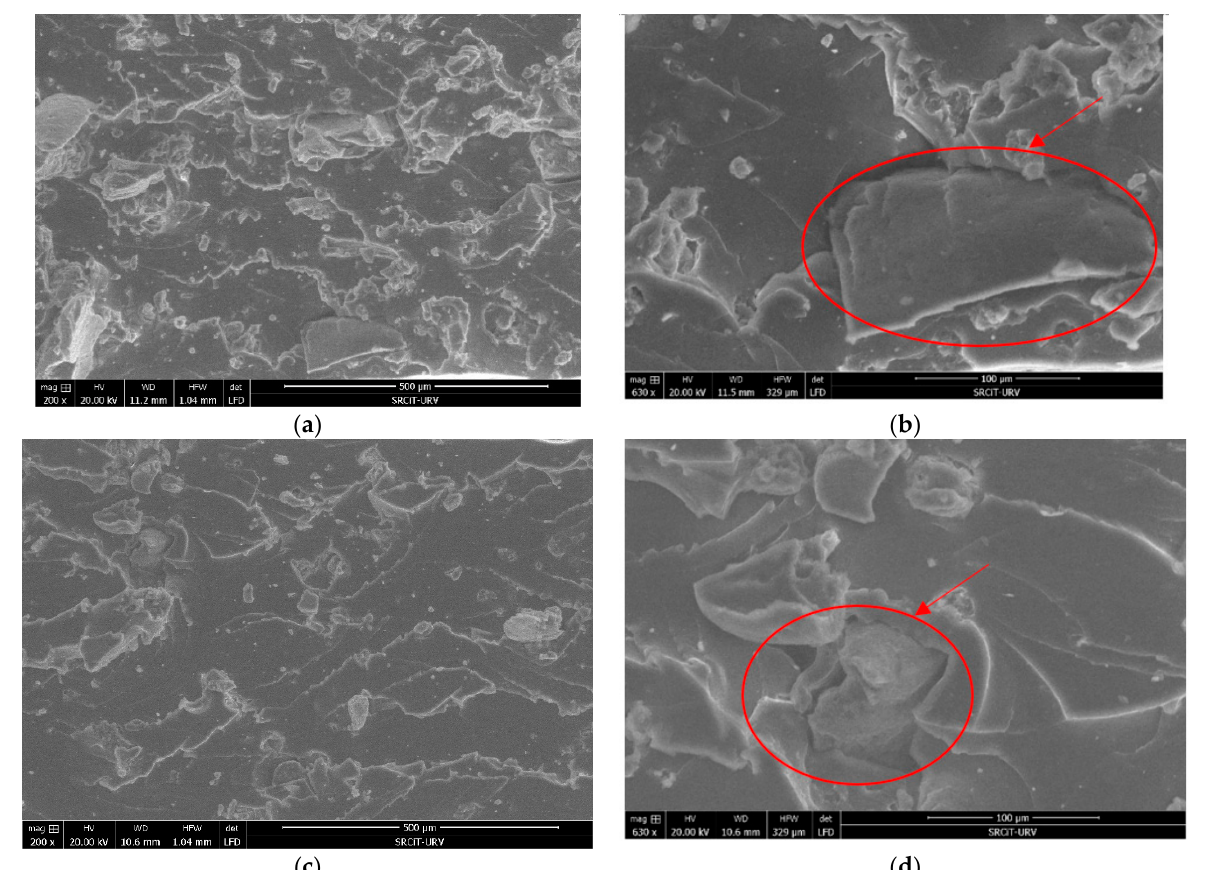
Figure 1. SEM micrographs of EDPM at 20% GTR ( a , b ) and at 10% GTR ( c , d ), and at different magnifications: 200 × ( a , c ) and 630× ( b , d ).